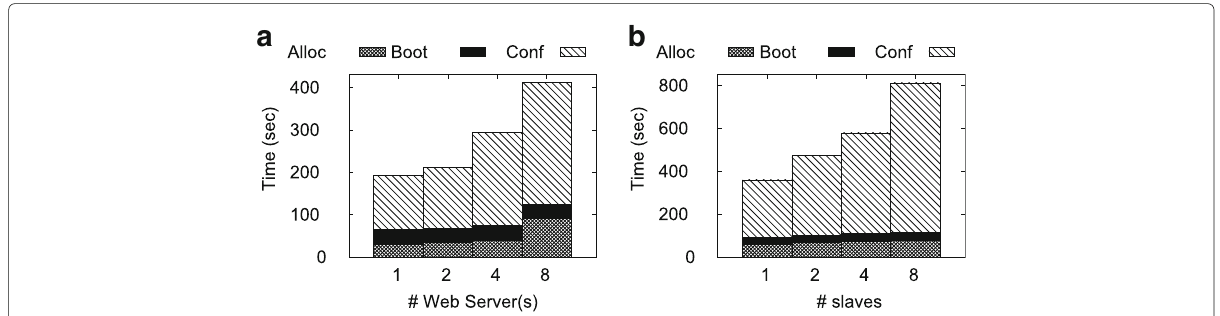
Fig. 7 Execution times of different deployment phases for varying module multiplicity using vanilla images. a Wordpress. b